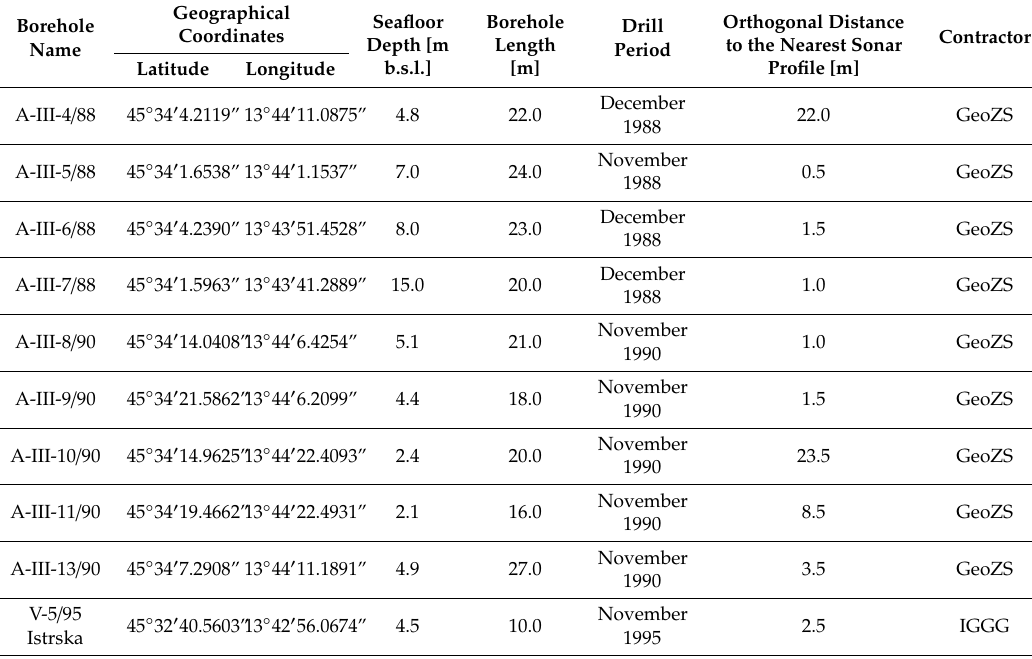
Figure 2. Study area. ( a ) Bay of Koper with borehole (white circles) and sub-bottom sonar profile locations (thick black lines). ( b ) and ( c ) close-ups of the studied areas with bathymetry indicated by thin grey lines. Red lines show the locations of sub-bottom sonar profiles presented in Figures 3 and 4. White circles indicate borehole locations. For clarity the “A-III-” prefix is not shown in ( b ). Table 1. Boreholes used in this study (GeoZS: Geological Survey of Slovenia; IGGG: Institute for Geology, Geotechnics and Geophysics